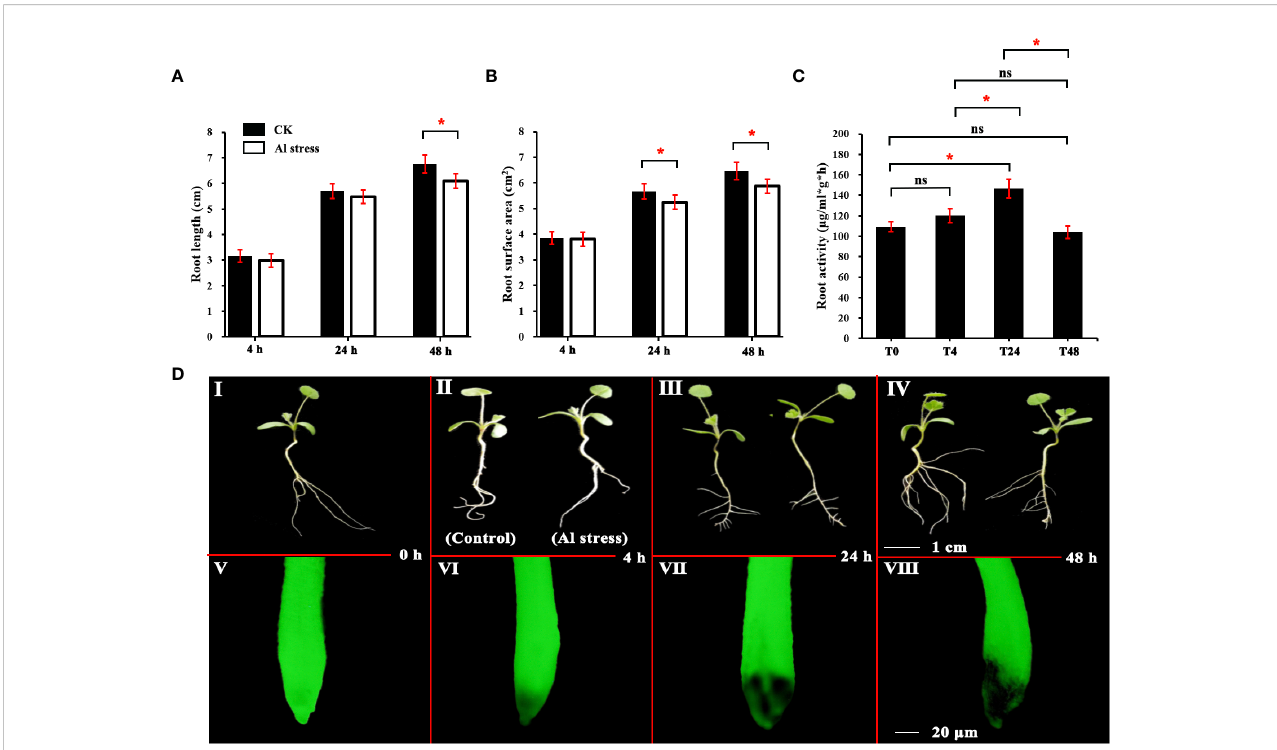
FIGURE 1 Analysis of root physiological characteristics of M. truncatula under aluminum stress. (A) Analysis of total root length of M. truncatula . (B) Analysis of root surface area of M. Truncatula . (C) Analysis of root activity of M. Truncatula . (D) I – IV is the growth comparison of plants under Al stress and the blank control at the same time point. Plant material grown under normal conditions and treated for the same amount of time as the corresponding aluminum treatment group were used as a control, scale = 1 cm; V – VIII is the comparison of root fl uorescence of plants under Al stress and the blank control after FDA staining, scale = 20 m m. * indicates that there is a signi fi cant difference at the level of 0.05 according to Duncan ’ s multiple range test, while ns indicates that the difference is not signi fi